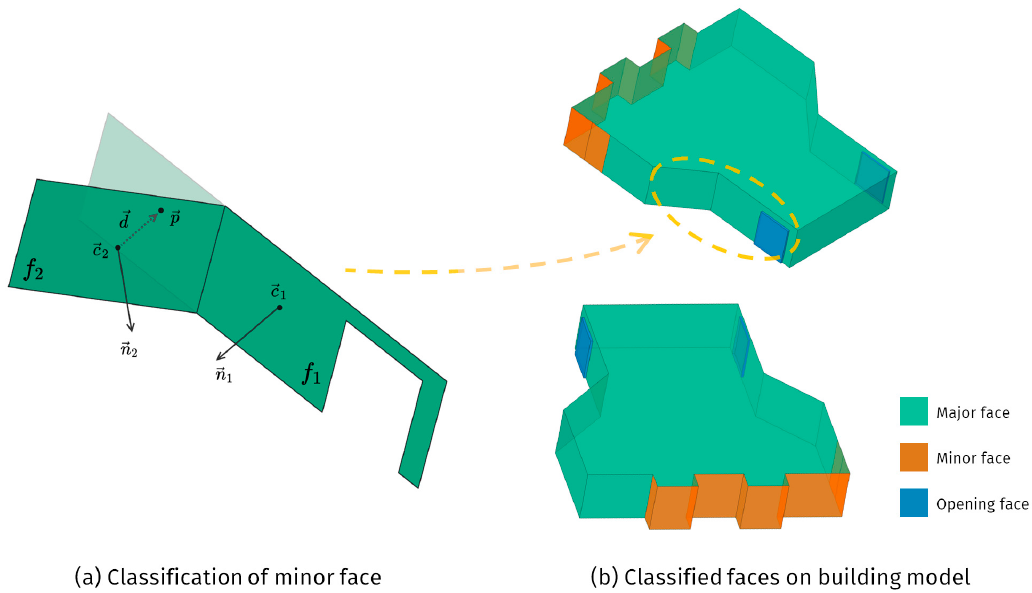
→ → c i is the center, n i is the unit normal of